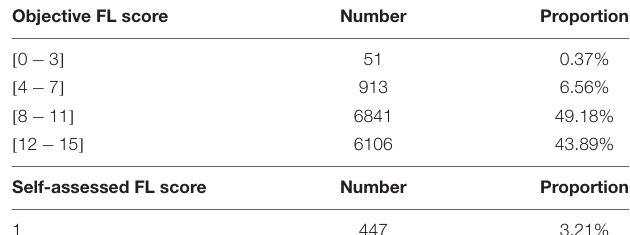
TABLE 1 | The summary of the response of objective, self-assessed, and composite FL.